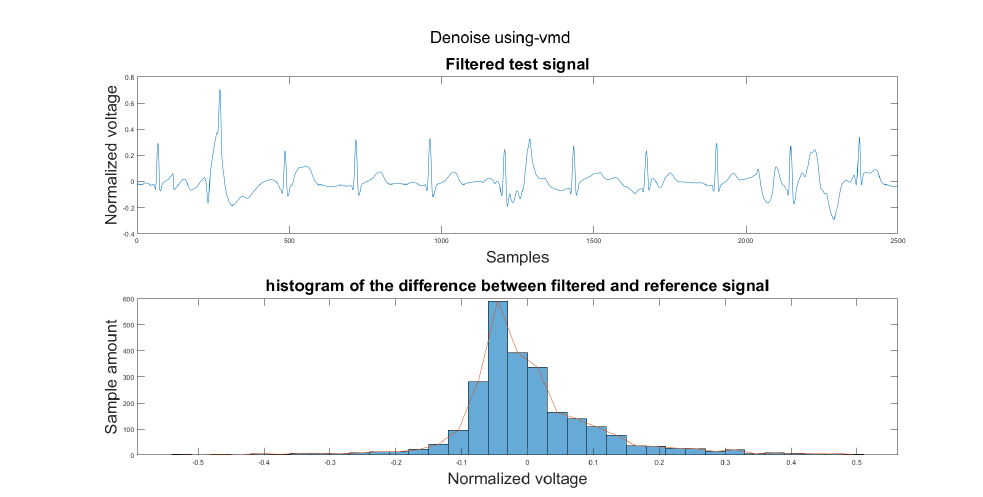
Figure A41. (1) Test signal, (2) histogram of the